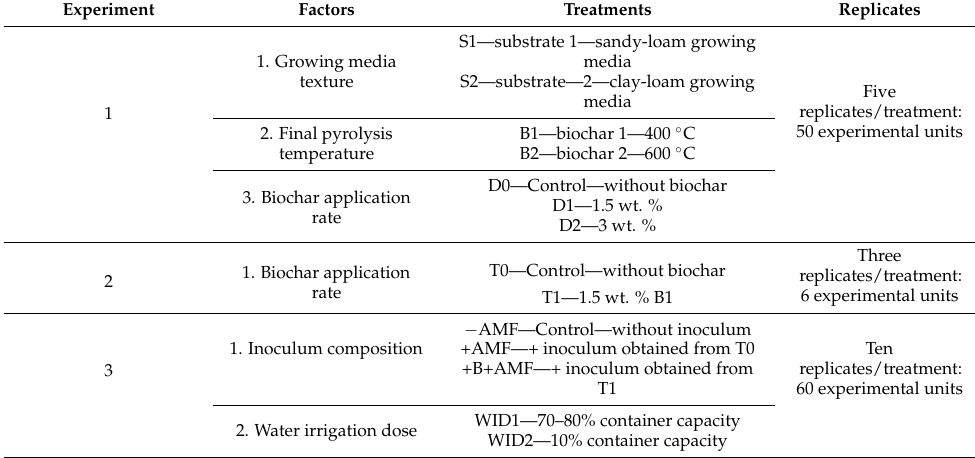
Table 6. Experimental designs adopted to evaluate the effects of biochar addition as a component of the solid substrate in the multiplication process of